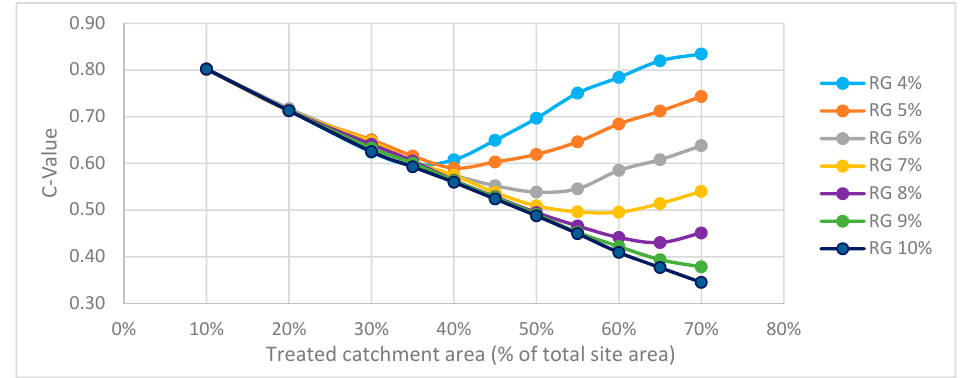
Figure A8. Mixed precinct results of effective C-value versus treated catchment area for various rain garden sizes.